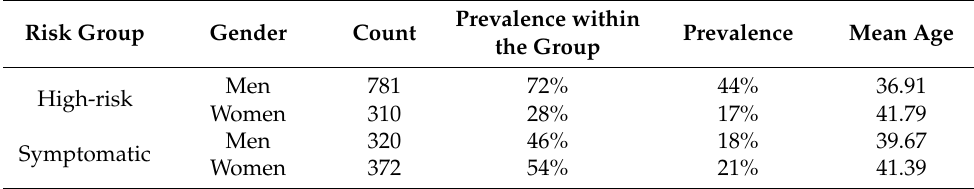
Table 1. Demographic characteristics of the study participants.